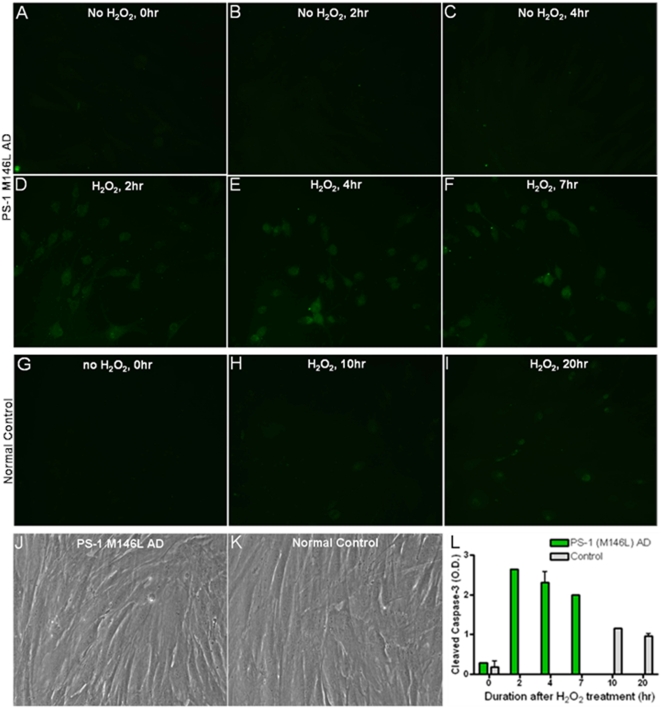
Hydrogen peroxide treatment results in heightened caspase-3 activation in PS-1 (M146L) AD fibroblasts.PS-1 (M146L) AD and control fibroblasts were treated with 500 µM H2O2 for 60 min and then re-fed with media for 0–20 hr to permit a post stress time window. Cells were methanol-fixed and analyzed by immunocytochemistry for cleaved caspase-3 with Alexa-488 labeled secondary antibody as described in Methods. Representative images of fields uniformly containing 35–40 cells were captured at time points designated (A–F). PS-1 (M146L) AD fibroblasts; (G–I) control fibroblasts. Representative phase contrast images of (J) control and (K) PS-1 (M146L) AD cells show comparable growth properties and cell densities at time of testing for oxidative stress responses. (L) Alexa 488 fluorescence intensity of cleaved caspase-3 immunostaining in PS-1 (M146L) fields A–F above and control fields G–I was quantitated via the MacBiophotonics Image J analysis program (www.macbiophotonics.ca/downloads.htm). Bar graph represents 2 independent experiments' mean and S.E.